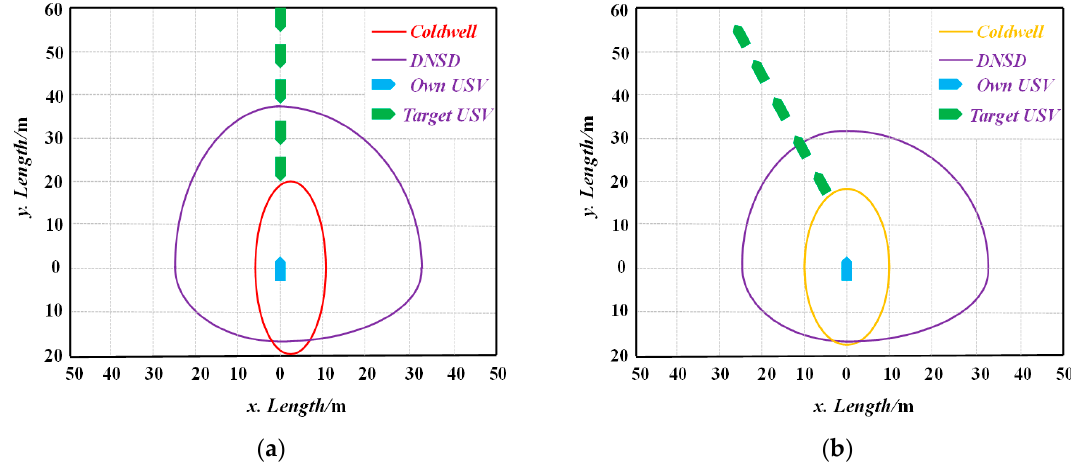
Figure 15. The DNSD model compared with the Coldwell model in head-on and overtaking encounter situations: ( a ) Head-on; ( b ) Overtaking.